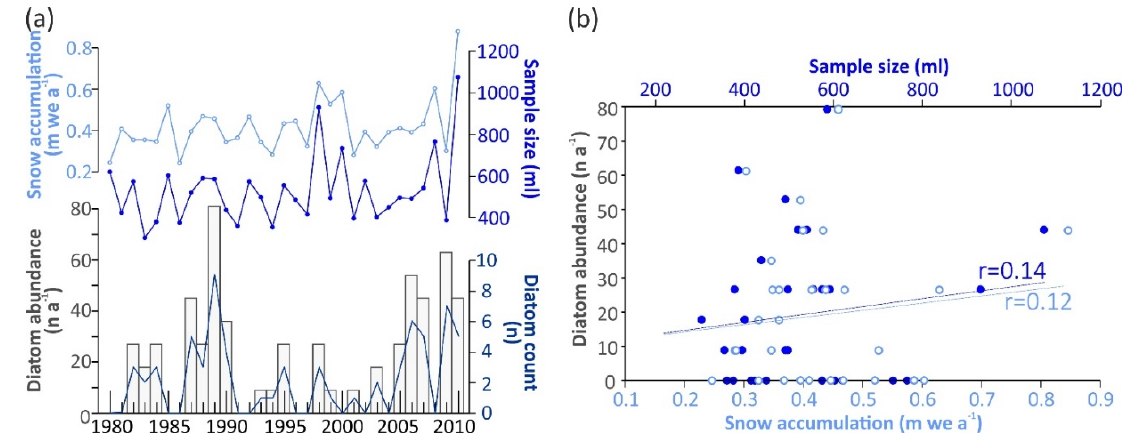
Figure 5. Comparison of diatom abundance with parameters of ice volume for 1980–2010. ( a ) Plots of diatom abundance, sample volume and water-equivalent (we) rate of snow accumulation and ( b ) correlation coefficients between diatom abundance, sample volume and water-equivalent (we) rate of snow accumulation.